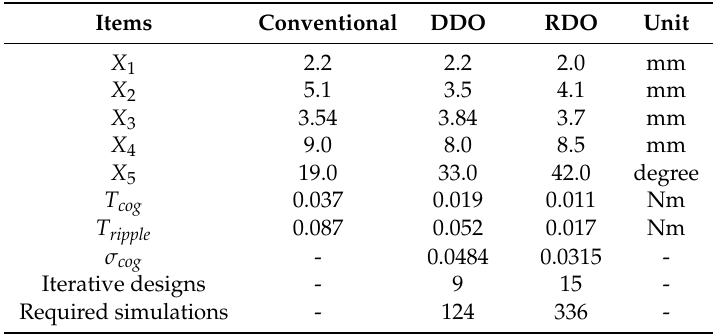
Table 4. Design values and characteristics.